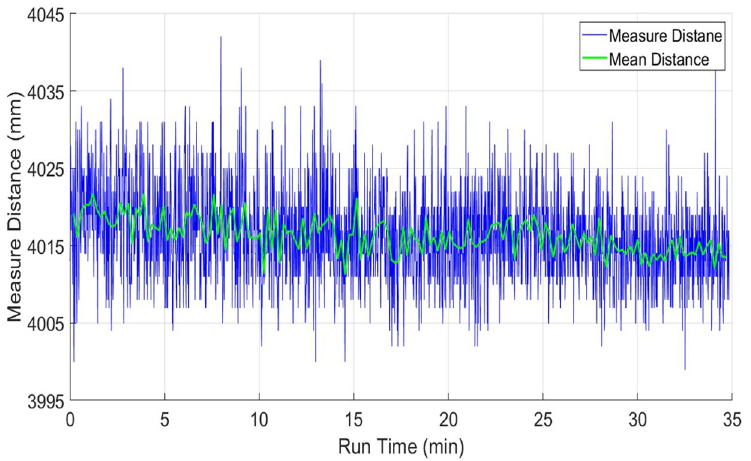
Fig 10. Drift test of RPLidar using range measurements of four-meter